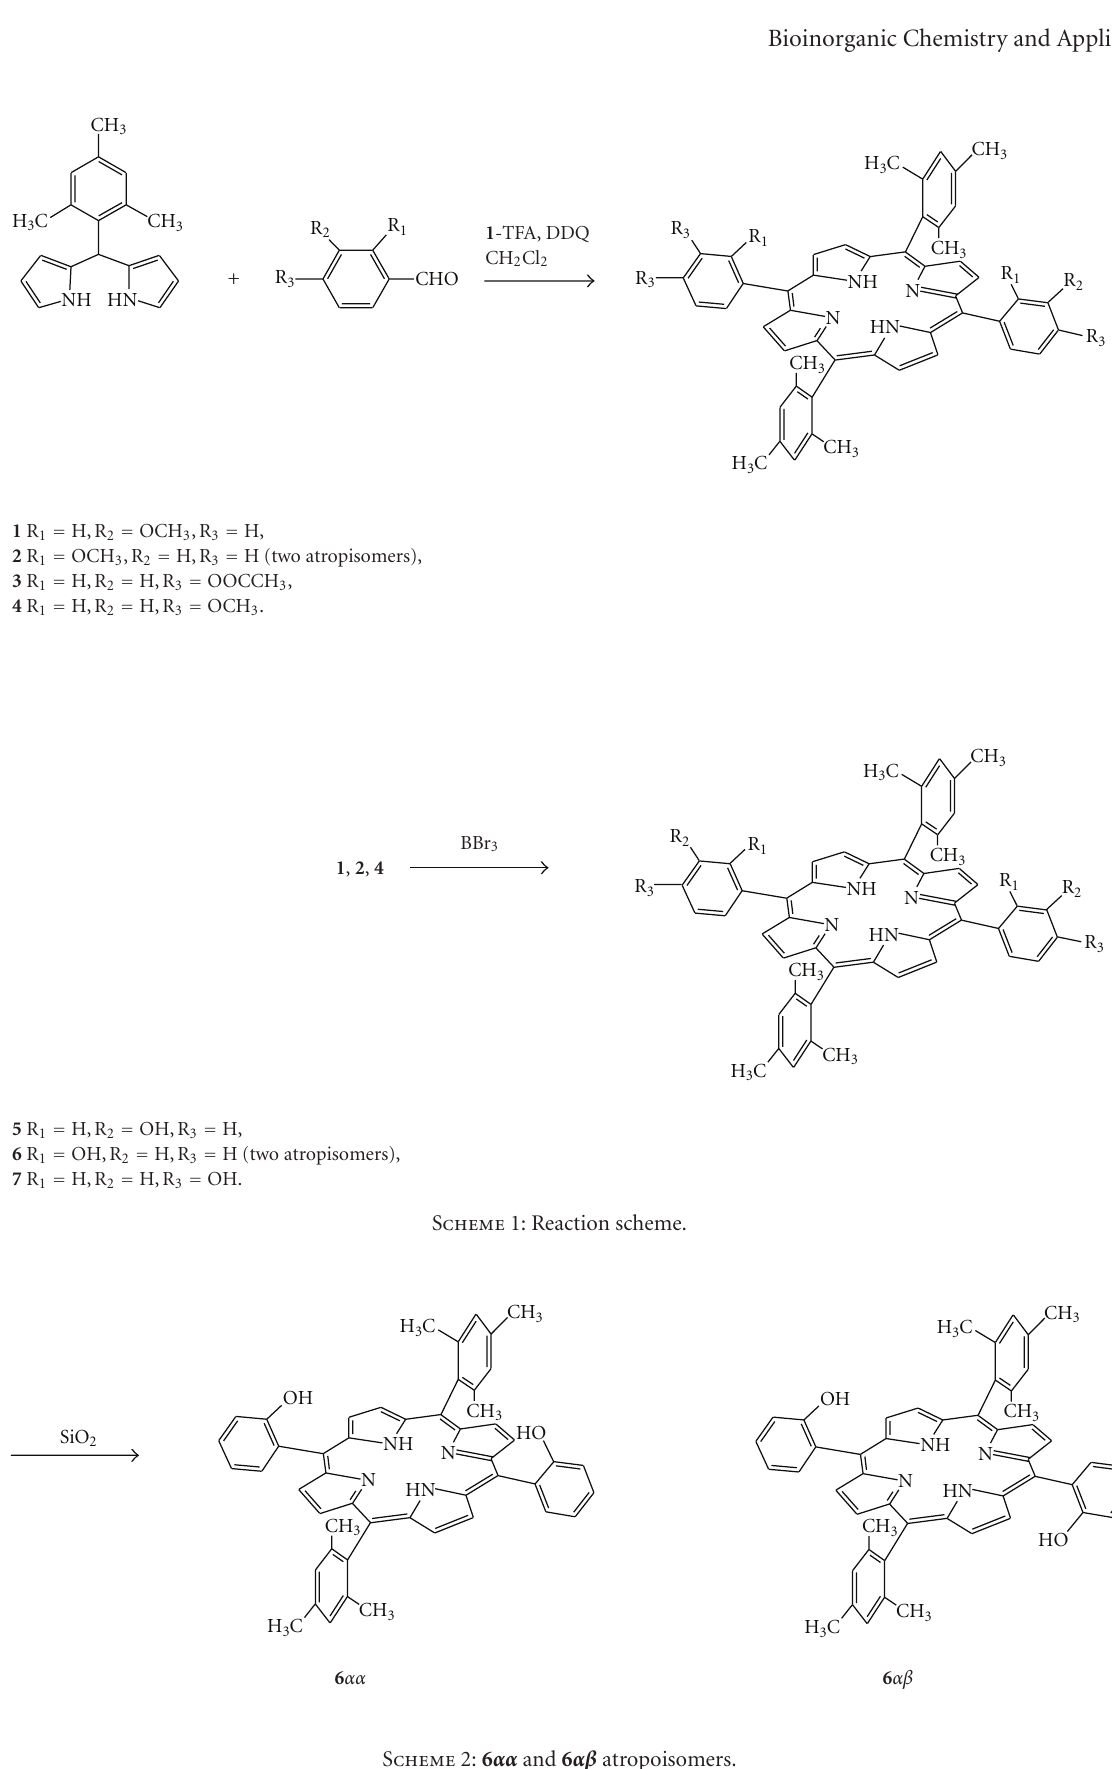
Scheme 2: 6 αα and 6 αβ